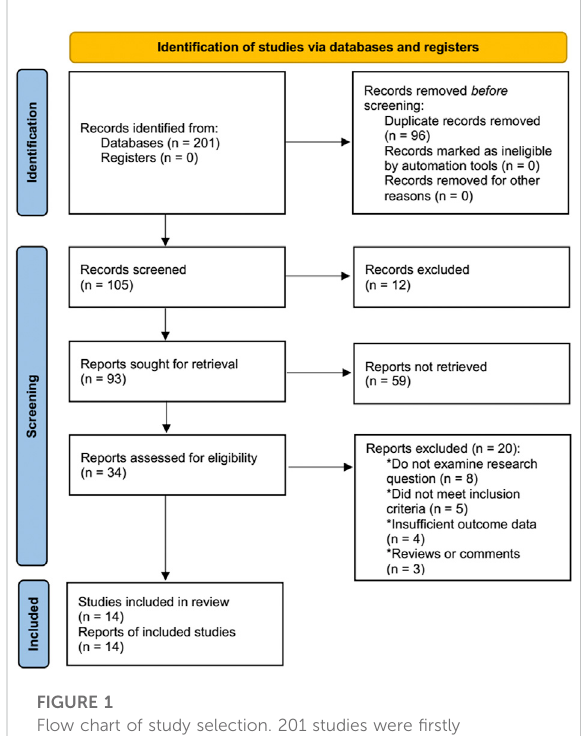
FIGURE 1 Flow chart of study selection. 201 studies were fi rstly identi fi ed and fourteen eligible studies were fi nally included after